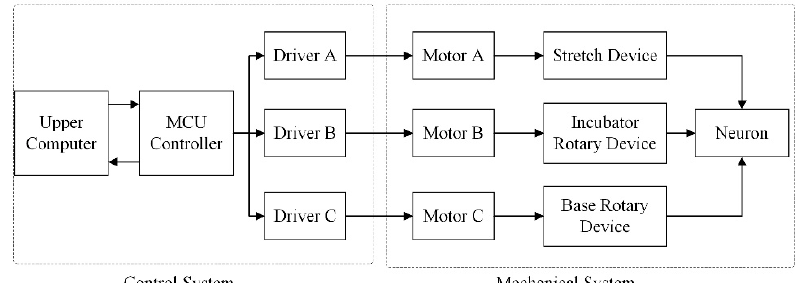
Figure 3. The control circuit of the cell stretch growth device.